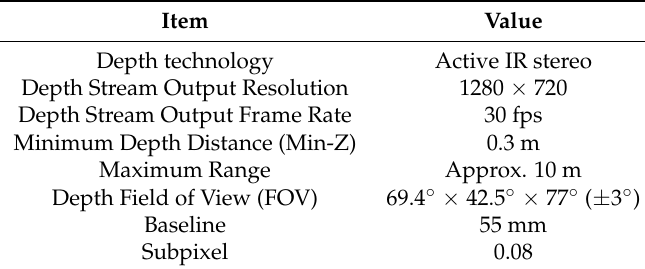
Figure 3. Intel R (cid:13) RealSense TM D415 depth camera. Table 1. The key specifications of Intel R (cid:13) RealSense TM